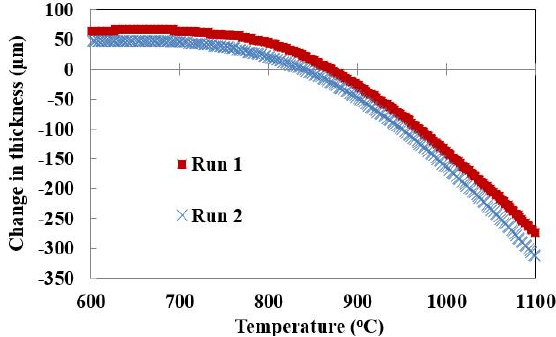
Figure 1. Reproducibility analysis of thermo ‐ mechanical analysis measurements.